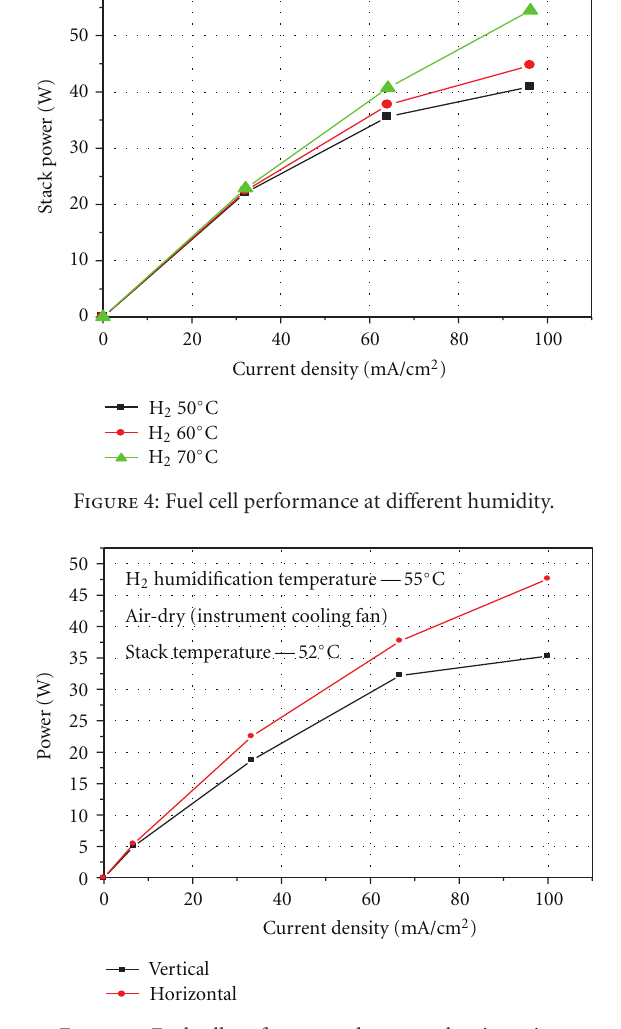
Figure 5: Fuel cell performance due to stack